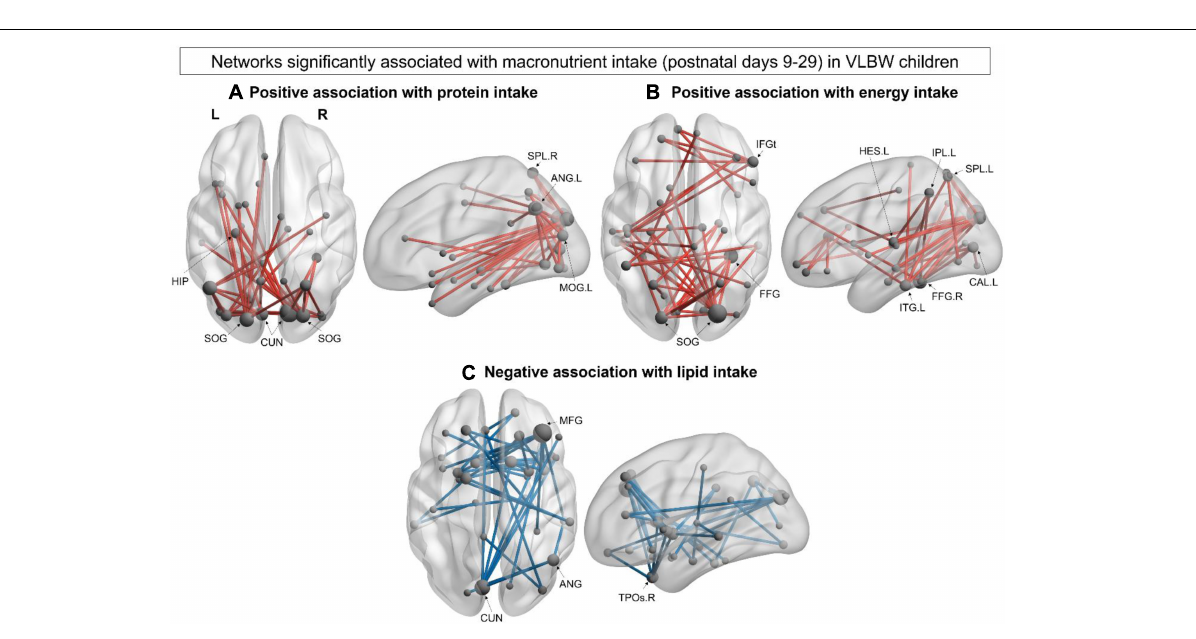
FIGURE 4 | Within-group network analysis: VLBW group. (A) Significant alpha-band (8–14 Hz) network positively associated with higher protein intake (40 edges, 31 nodes, p corr = 0.032) in VLBW children. (B) Significant alpha-band (8–14 Hz) network positively associated with energy intake (40 edges, 36 nodes; p corr = 0.034). (C) Significant beta-band (15–29 Hz) negatively associated with lipid intake (41 edges, 37 nodes, p corr = 0.007). Node size is scaled by